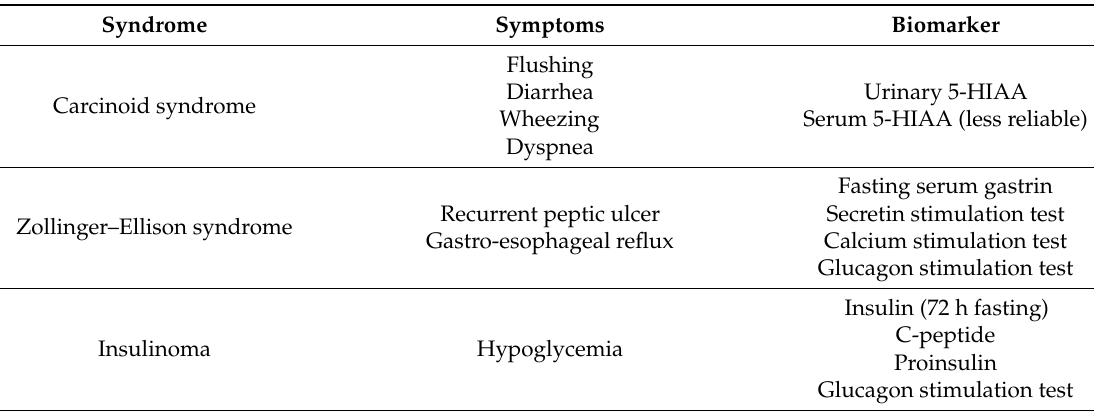
Table 2. Expression of di ff erent non-specific markers according to clinical manifestations. Features of tumors gastroenteropancreatic-neuroendocrine (GEP-NET)-associated clinical syndromes. 5-HIAA: 5-hydroxy-indolacetic acid; VIP: vasoactive intestinal